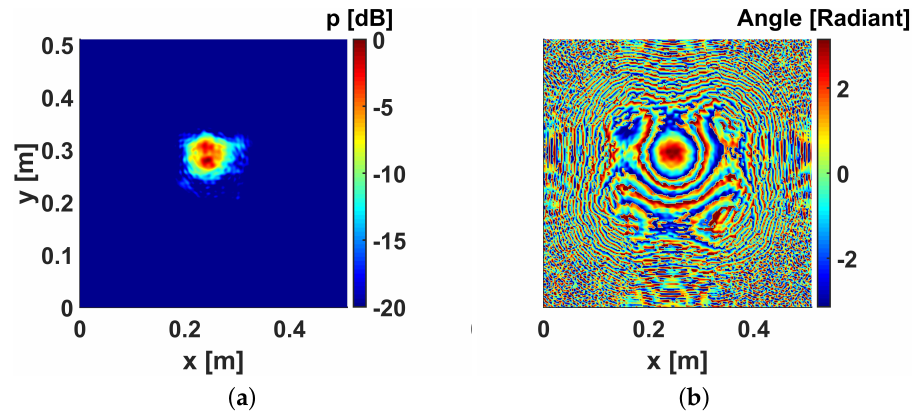
Figure 8. Amplitude ( a ) and angle ( b ) at the top of the wooden particleboard without a flaw. Evaluated with the spec-radiation method for the frequency 50kHz, with d x = d y = 2 mm and a grid of the size 256 × 256